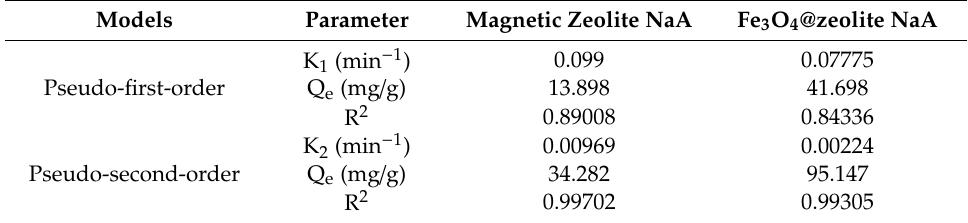
Figure 12. Pseudo-first order model ( a ) and pseudo-second order model ( b ) fittings for Cu 2 + adsorption onto magnetic zeolite NaA and Fe 3 O 4 @zeolite NaA. Table 4. Kinetics constants for adsorption by magnetic zeolite NaA and Fe 3 O 4 @zeolite